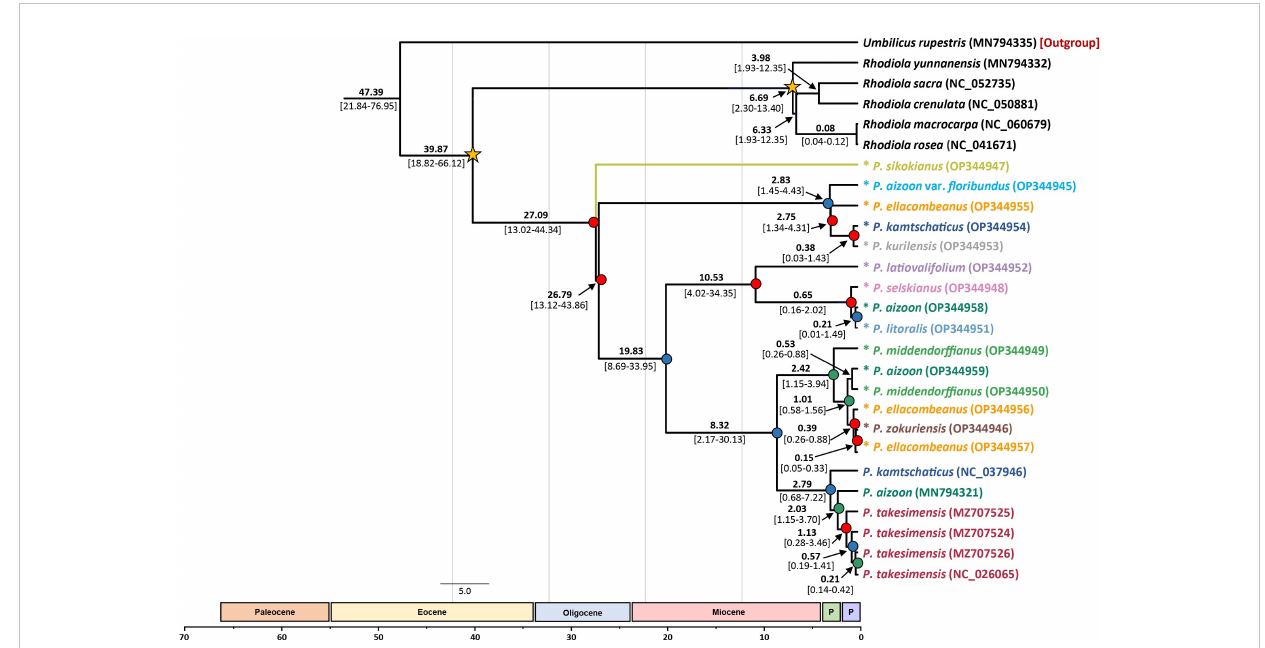
FIGURE 6 Dated chronogram showing divergence time of 21 accessions of subg. Aizoon plastomes. Estimated mean ages are shown for each node, with 95% high posterior density (HPD) in brackets. Internal node posterior probability (PP) is shown in red (PP ≥ 0.95), blue (0.95> PP >0.75), and green (0.75 >PP). Two calibration points are shown as asterisked nodes based on a previous study (Messerschmid et al.,